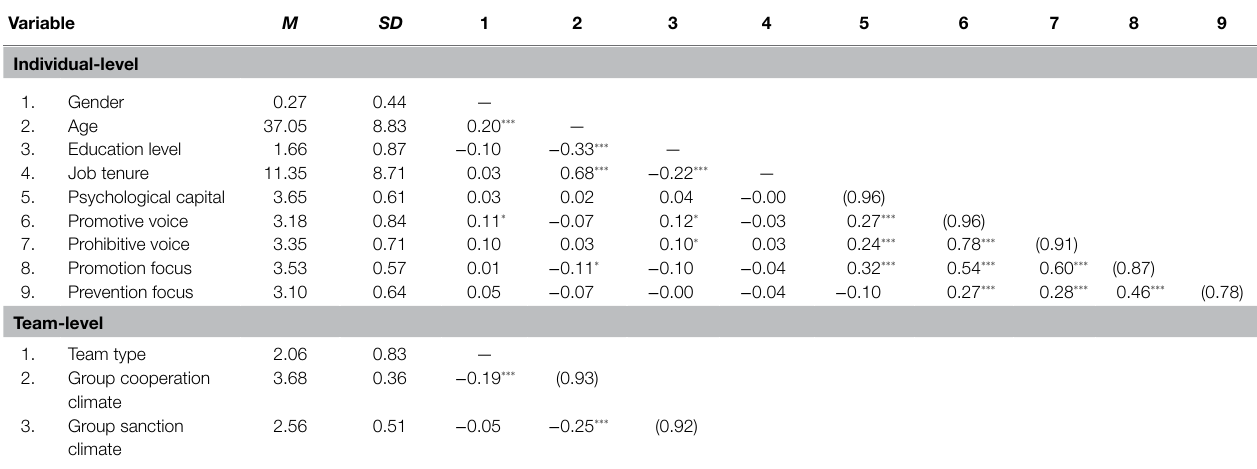
TABLE 1 | Mean, standard deviation, correlations, and reliabilities among studied variables.